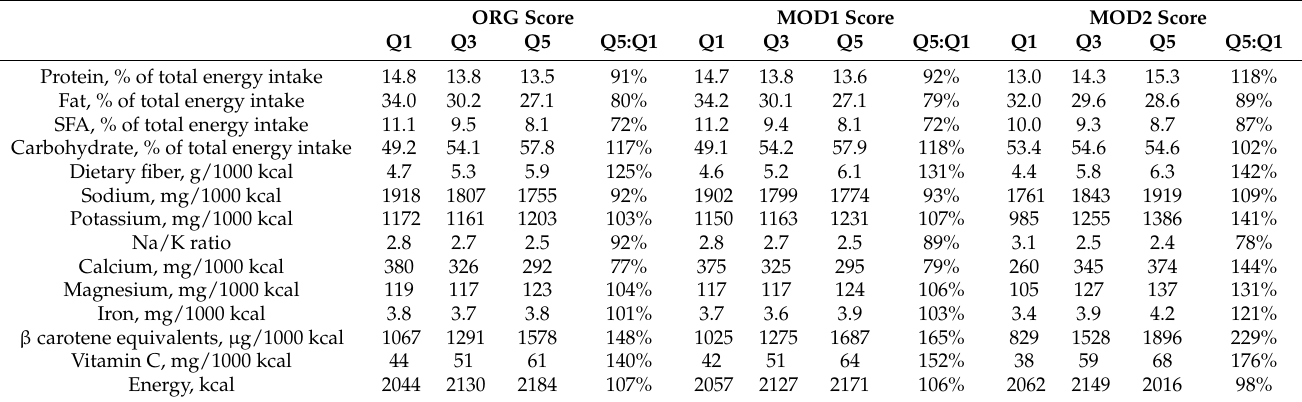
Table 4. Median intake of nutrients among quintile categories of the diet quality scores.